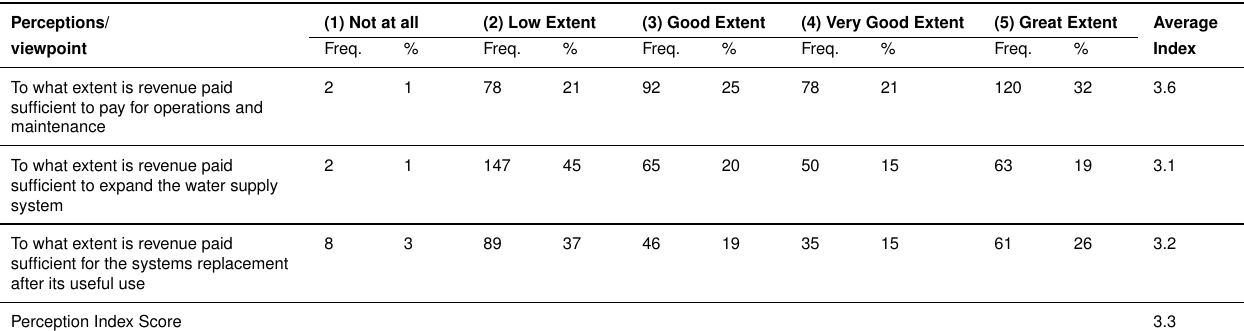
Table 5. Perception Index on the extent of revenue sufficiency for operations and maintenance, expansion and/or